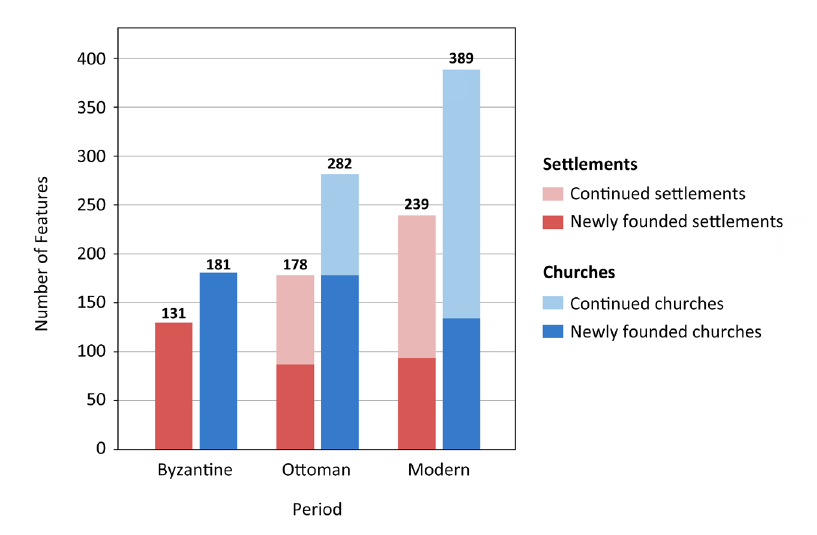
Figure 5. Total number of churches and settlements in each period.